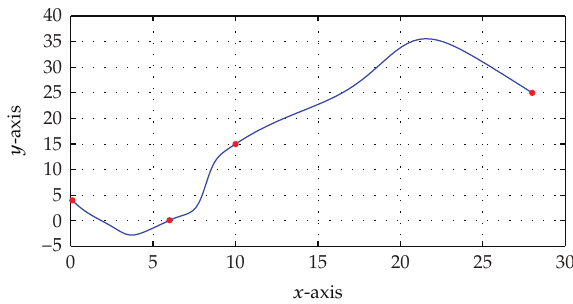
Figure 3: C 1 rational trigonometric cubic function with α i (cid:8) 0 . 5 , β i (cid:8) 1 . 0 , γ i (cid:8) 0 . 5 , and δ i (cid:8) 1 . 0.